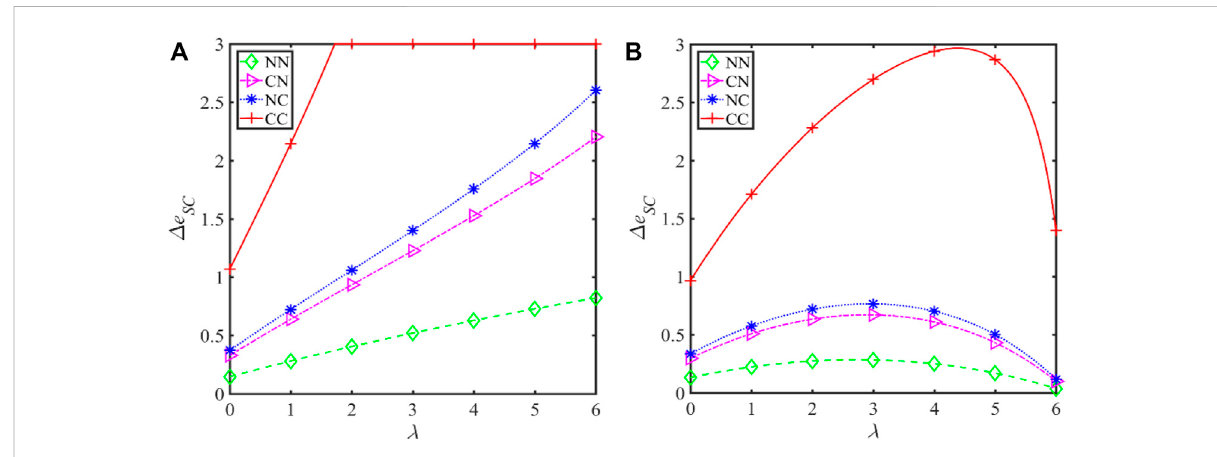
FIGURE 6 Impact of carbon tax rate on optimal carbon emission reductions. (A) Initial carbon emission e m 0 + e t 0 (cid:2) 3. (B) Initial carbon emission e m 0 + e